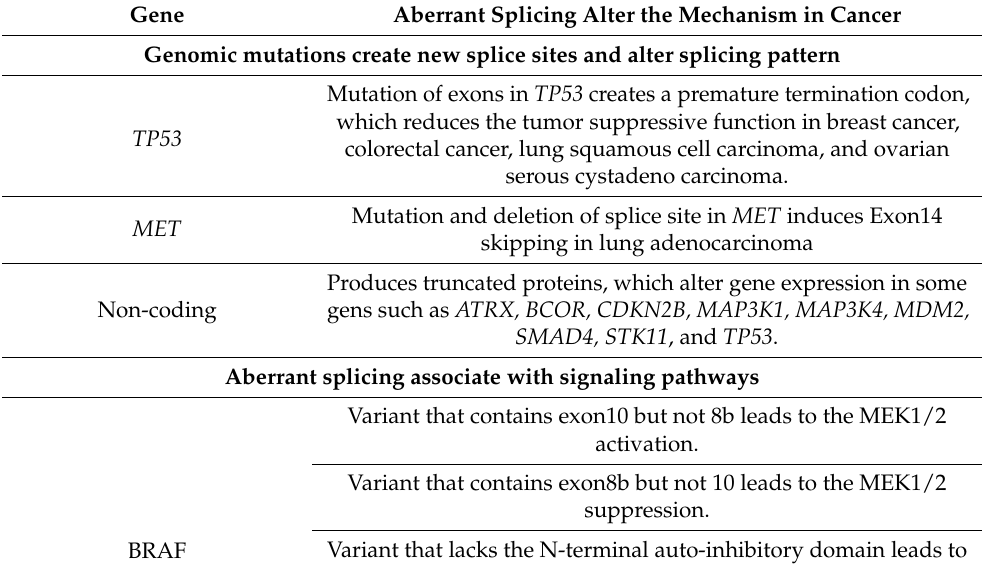
Table 2. Aberrant splicing depending on gene mutations or splicing variants in